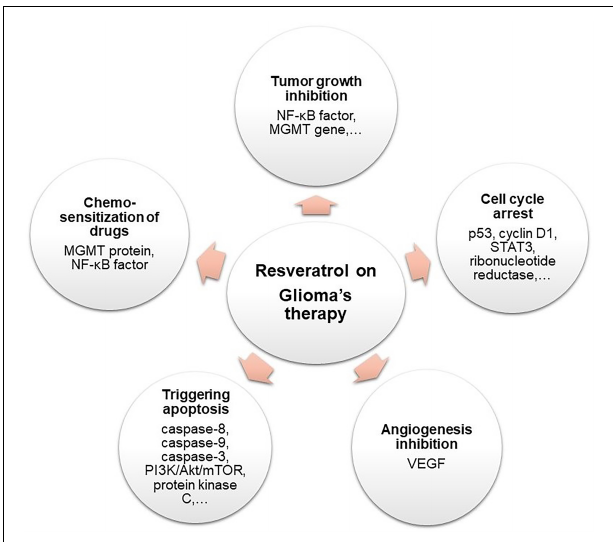
FIGURE 5 | Schematic representation of RES pharmacological activities on glioma